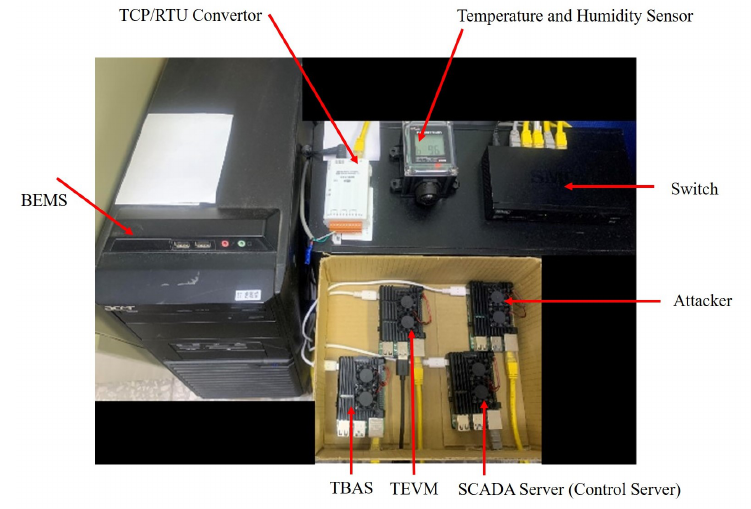
Figure 4. The setup of simulation environment.